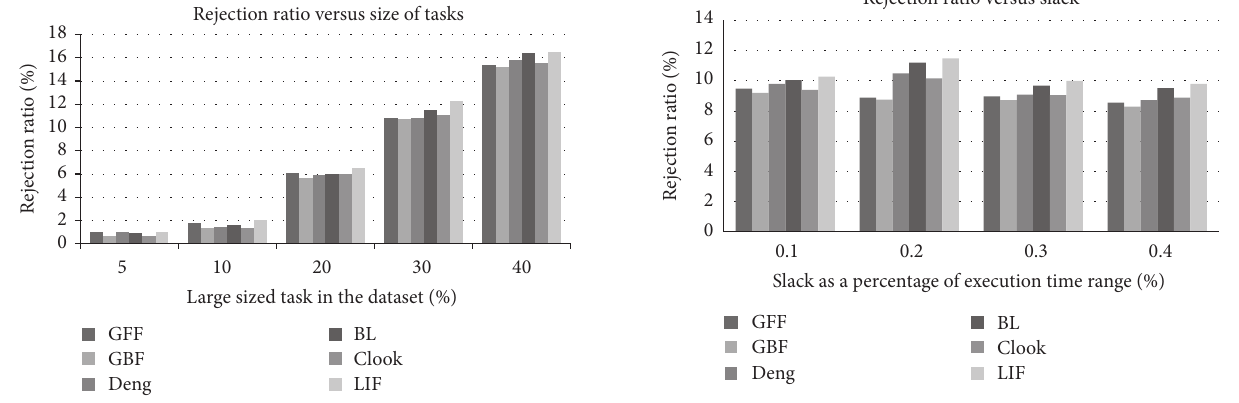
Figure 6: Rejection ratio decreases with increase in